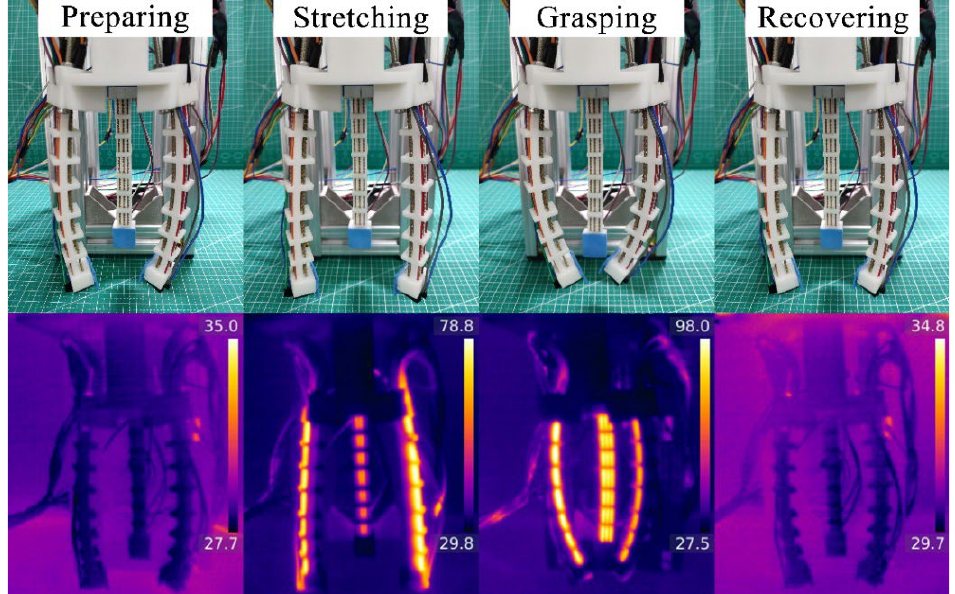
Figure 12. The whole gripping process without a load. Definitions of the four stages with their infrared thermograms during the grasping process.